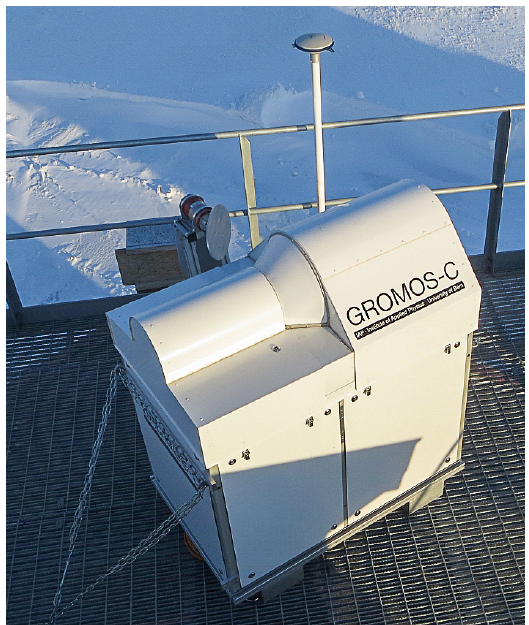
Figure 1. The ground-based microwave radiometer GROMOS-C at the AWIPEV research base at Ny-Ålesund, Svalbard (79 ◦ N, 12 ◦ E). Eastward and westward observations are performed through a coni- cal Teflon window with a rotating mirror inside the housing. North- ward and southward observations are performed via an external ro- tating